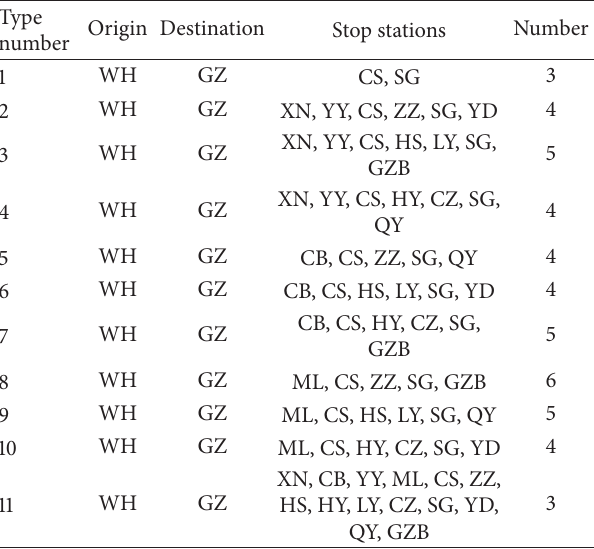
Algorithm 3 is developed with computer language